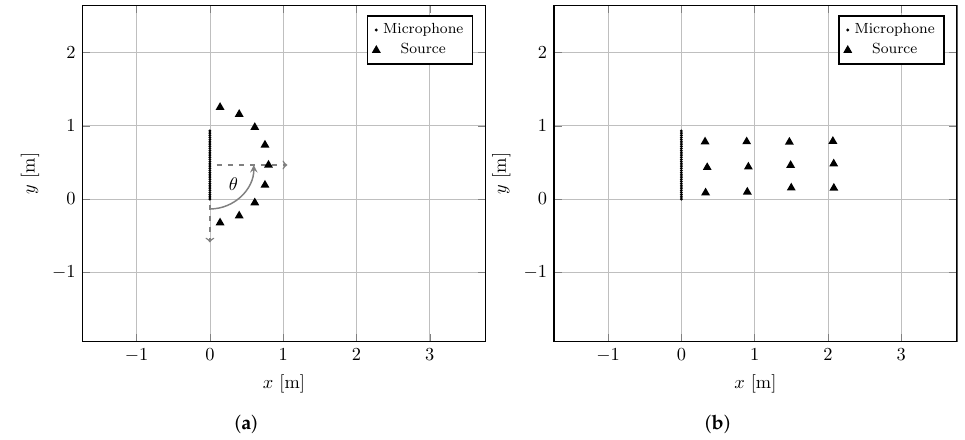
Figure 4. 2D graphical representation of the simulated setups (top view). The microphones of the ULA are depicted as black dots, while the sources are represented as black triangles. The elements are scaled with respect to the room dimensions, hence the distance between adjacent microphones of the ULA is barely noticeable. ( a ) Variable DOA ( θ ) and ( b ) 12 sources setups. The RIRs between microphones of the ULA and sources have been generated using the image source method [57,58] with 8 kHz sampling rate and c = 343 m s − 1 . The stacks of the simulated RIRs constitute the RIR images H (2). The